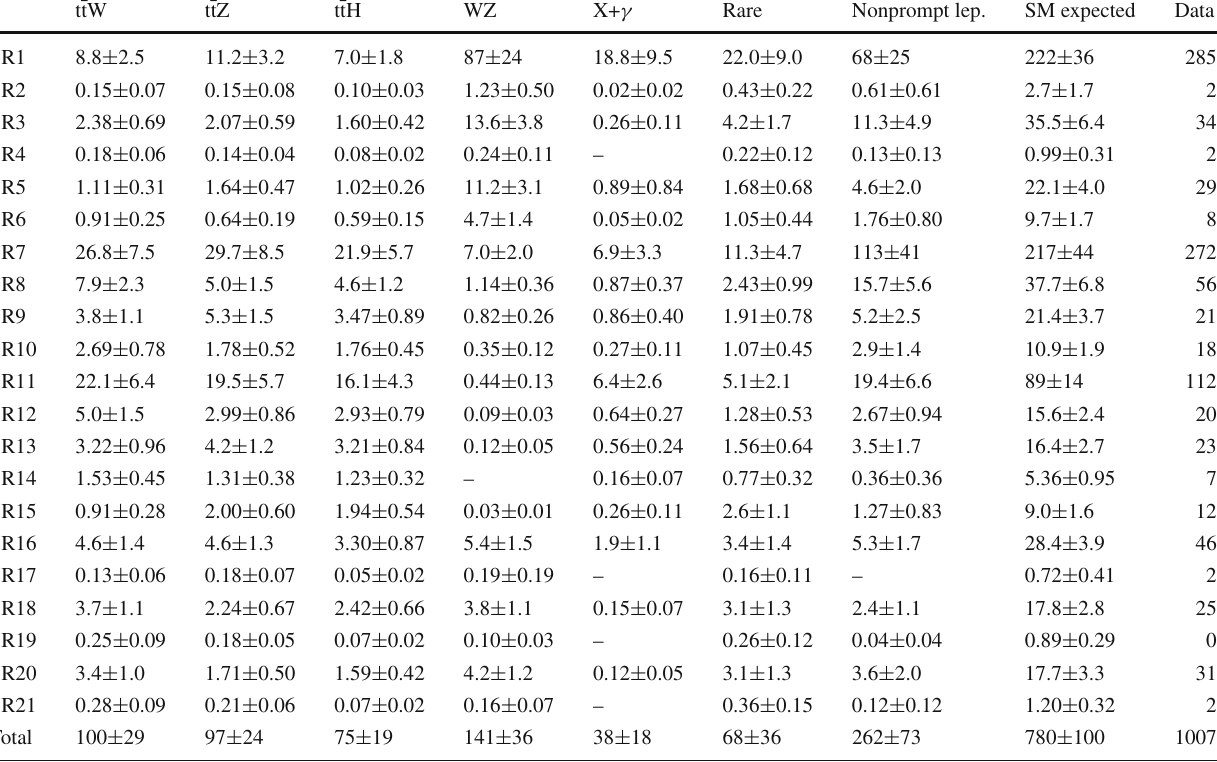
Table 15 Event yields in off-Z ML regions. Yields shown as “–” have a contribution smaller than 0.01, or do not contribute to a particular